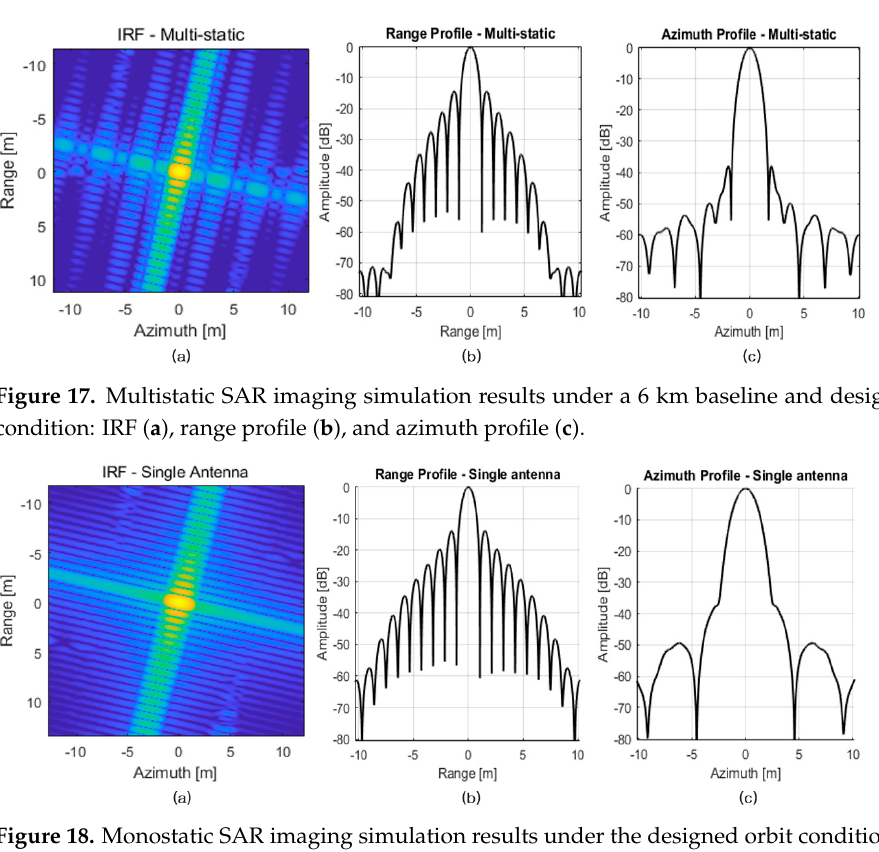
Figure 18. Monostatic SAR imaging simulation results under the designed orbit condition: IRF ( a ), range profile ( b ), and azimuth profile ( c ).